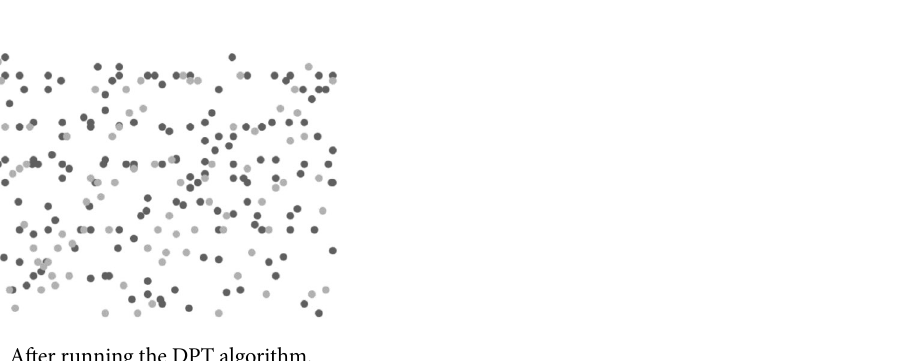
Figure 8. After running the DPT